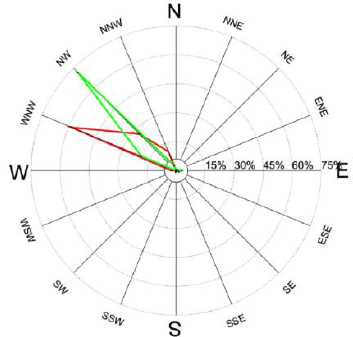
Figure 3. The wind rose diagram on the southwest and northeast sides (2D anemometer).